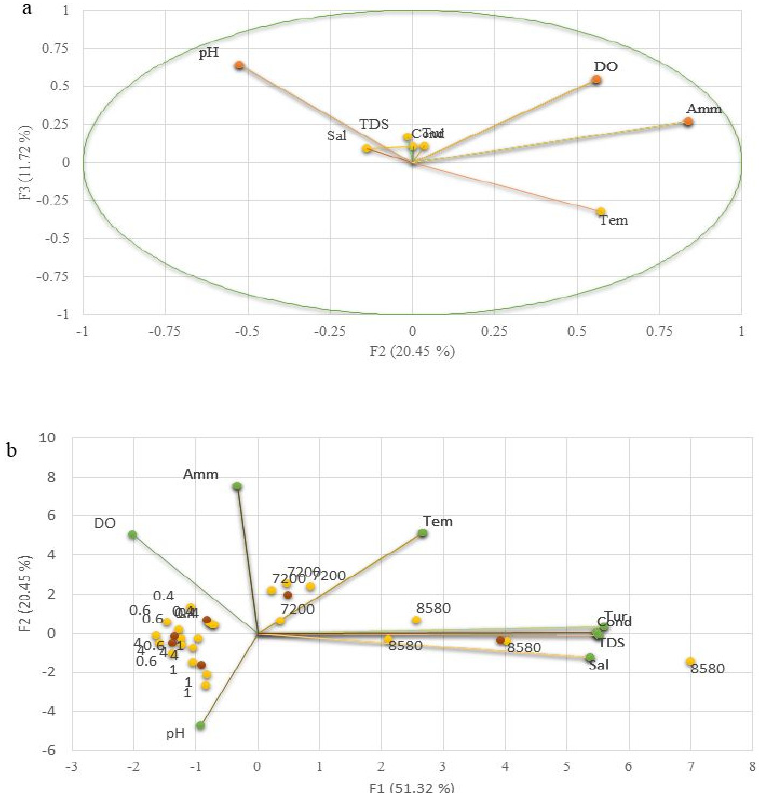
Figure 7. Principal component analysis (PCA). Station with water quality parameters ( a ), and spawning data with water quality parameters ( b ).